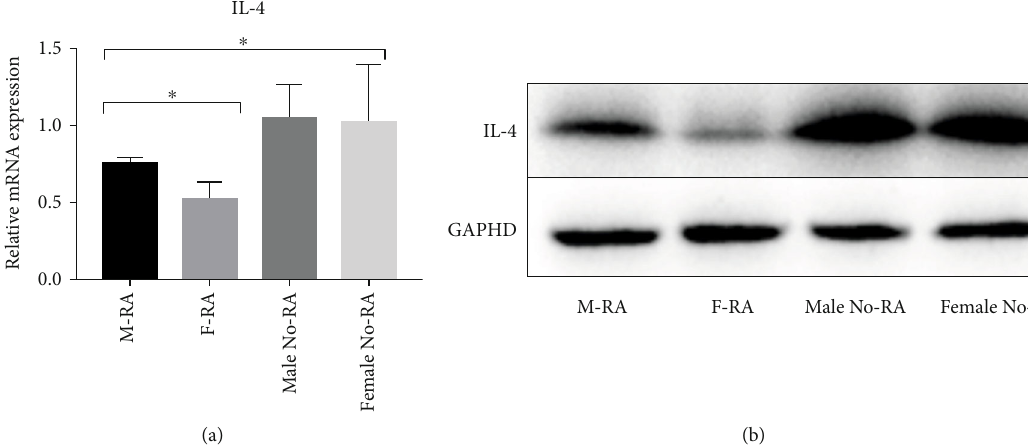
Figure 8: The expression of IL-4 in the RA group was lower than that in the No-RA group ( P < 0 : 05 ). The expression of IL-4 in the F-RA group was lower than that in the M-RA group ( P < 0 : 05 ). (a) Quantitative real-time PCR. (b) Western blot analysis. ∗ P < 0 : 05